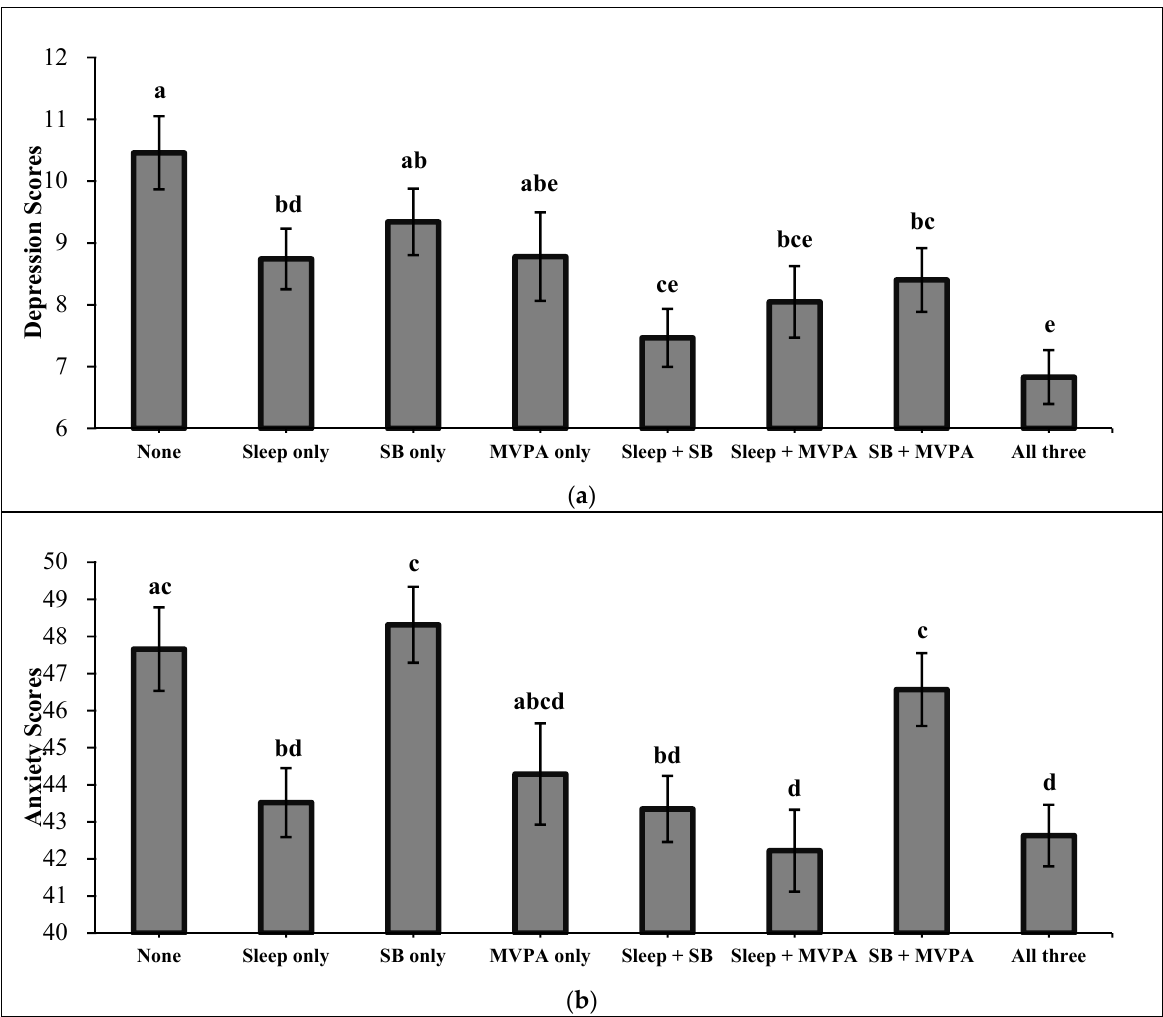
Figure 2. ( a ) Levels of depression according to different combinations of guidelines met. ( b ) Levels of anxiety according to different combinations of guidelines met. Note. Results are from multivariate analysis of covariance and pairwise post-hoc comparisons (Bonferroni test). Letters are denoted to mark the differences between groups. Groups with the same letter are not significantly different and groups that are significantly different get different letters. The error bars represent the 95% confidence intervals of standard error. Results are adjusted for age, gender, body mass index, family structure, parents’ educational level, number of siblings, number of friends, residence, and perceived family affluence. SB = meet the sedentary guideline; MVPA = meet the moderate-to-vigorous physical activity guideline.